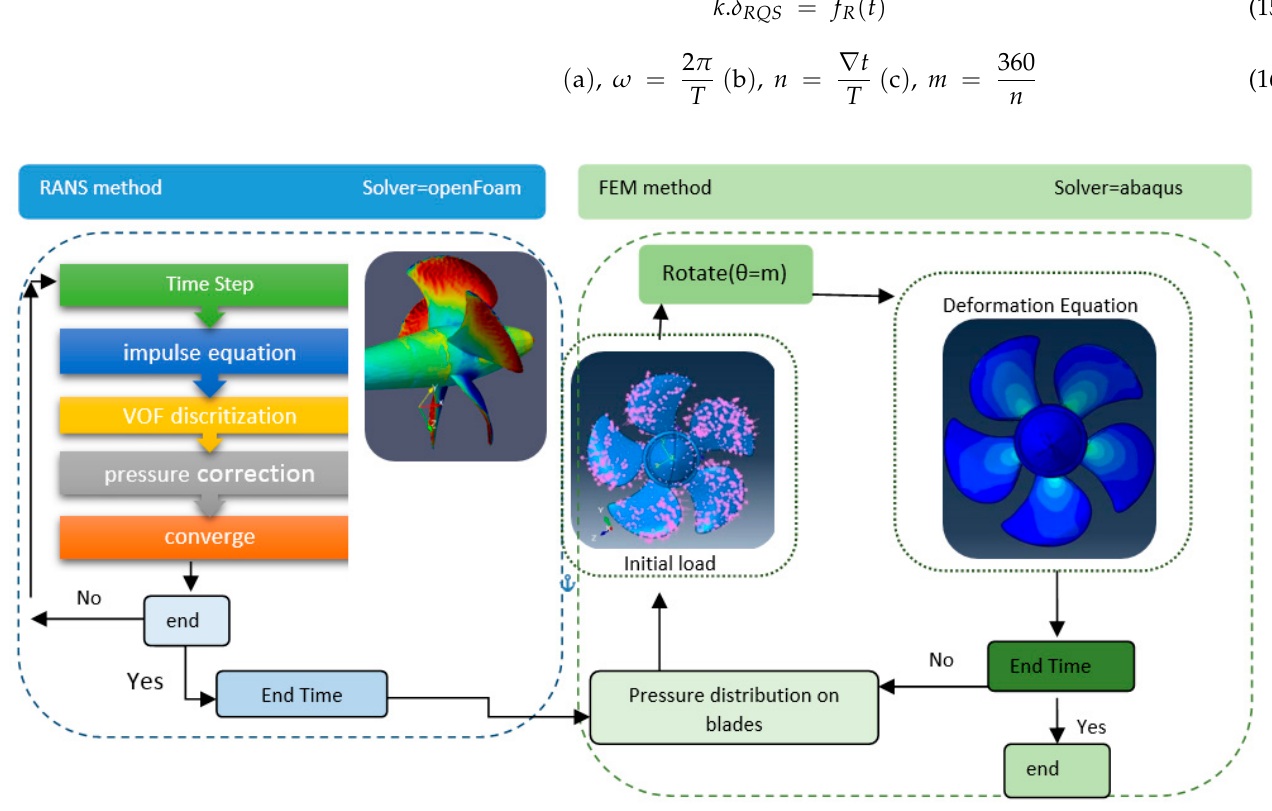
Figure 8. The comprehensive chart of the present method by considering the solvers engaged. In more detail, the FEM part of the method could involve a set of data for different Table 9. The datasheet for the coupling procedure of v = 5 m/s test case. cases in each time step; the rotation rate is constant for all advance coefficients due to constant rotational speed ( ω = 15 rps). The rotational rate is obtained at each time step